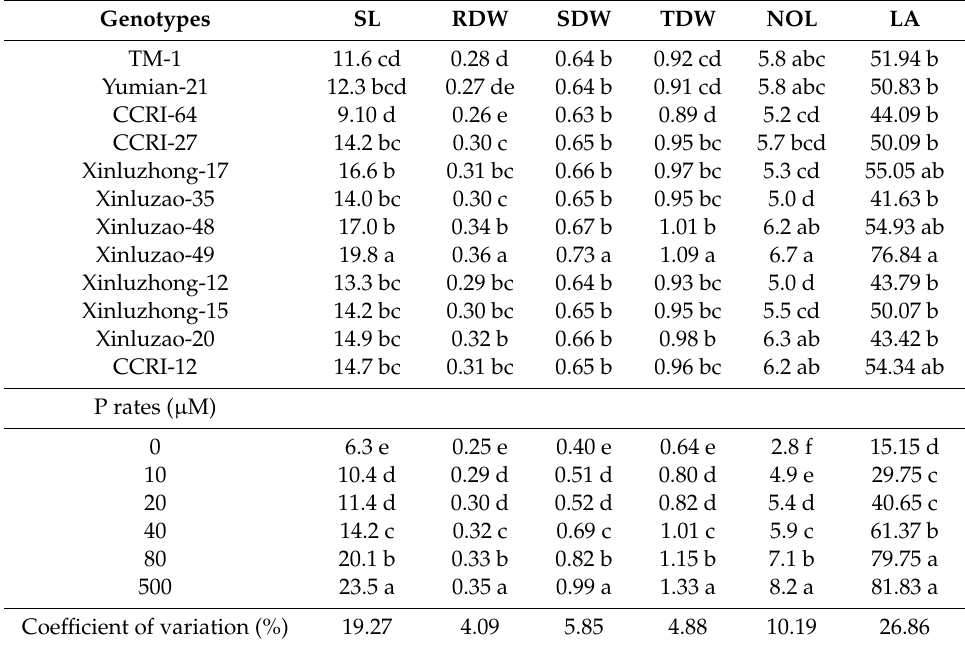
Table 1. Shoot length (SL, cm), root dry weight (RDW, g), shoot dry weight (SDW, g), total plant dry weight (TDW, g), number of leaves (NOL), and leaf area (LA, cm 2 ) of 12 cotton genotypes grown at di ff erent P concentrations in hydroponic